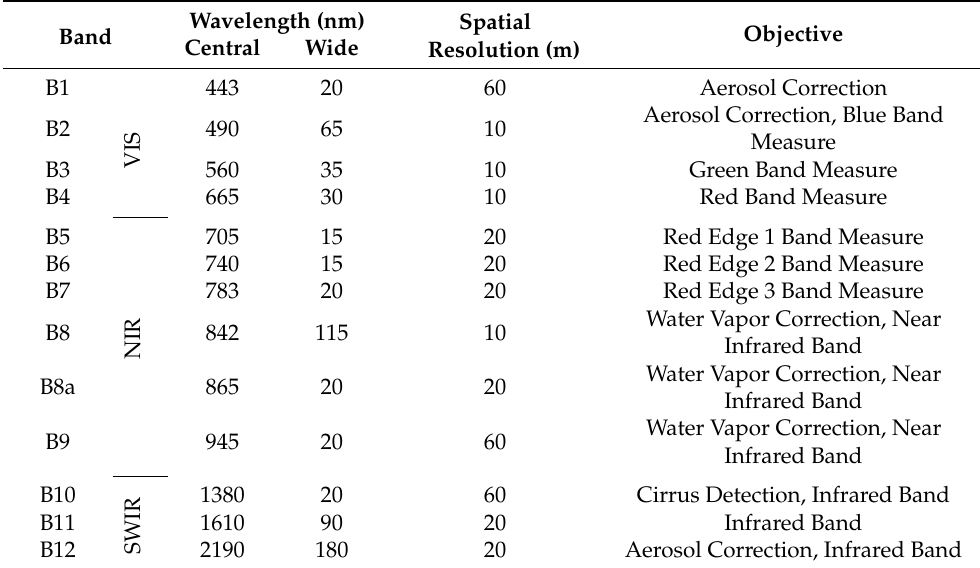
Table 1. Sentinel-2 spectral bands: Visible (VIS), Near-infrared (NIR) and Short-Infrared (SWIR), according to ESA [21]. Wavelength (nm) Spatial Band Resolution